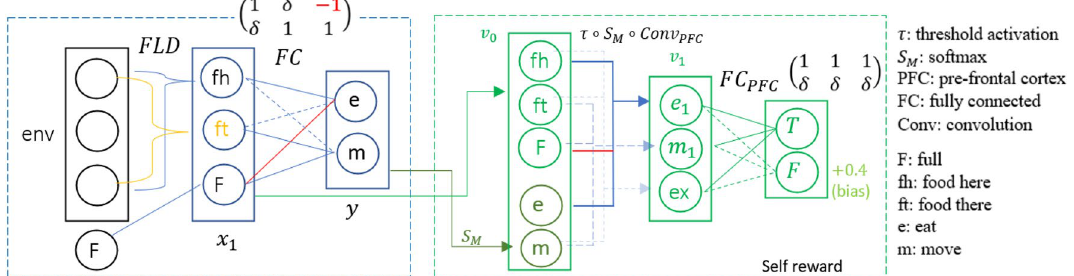
Figure 2. FishNN architecture, δ > 0 a small